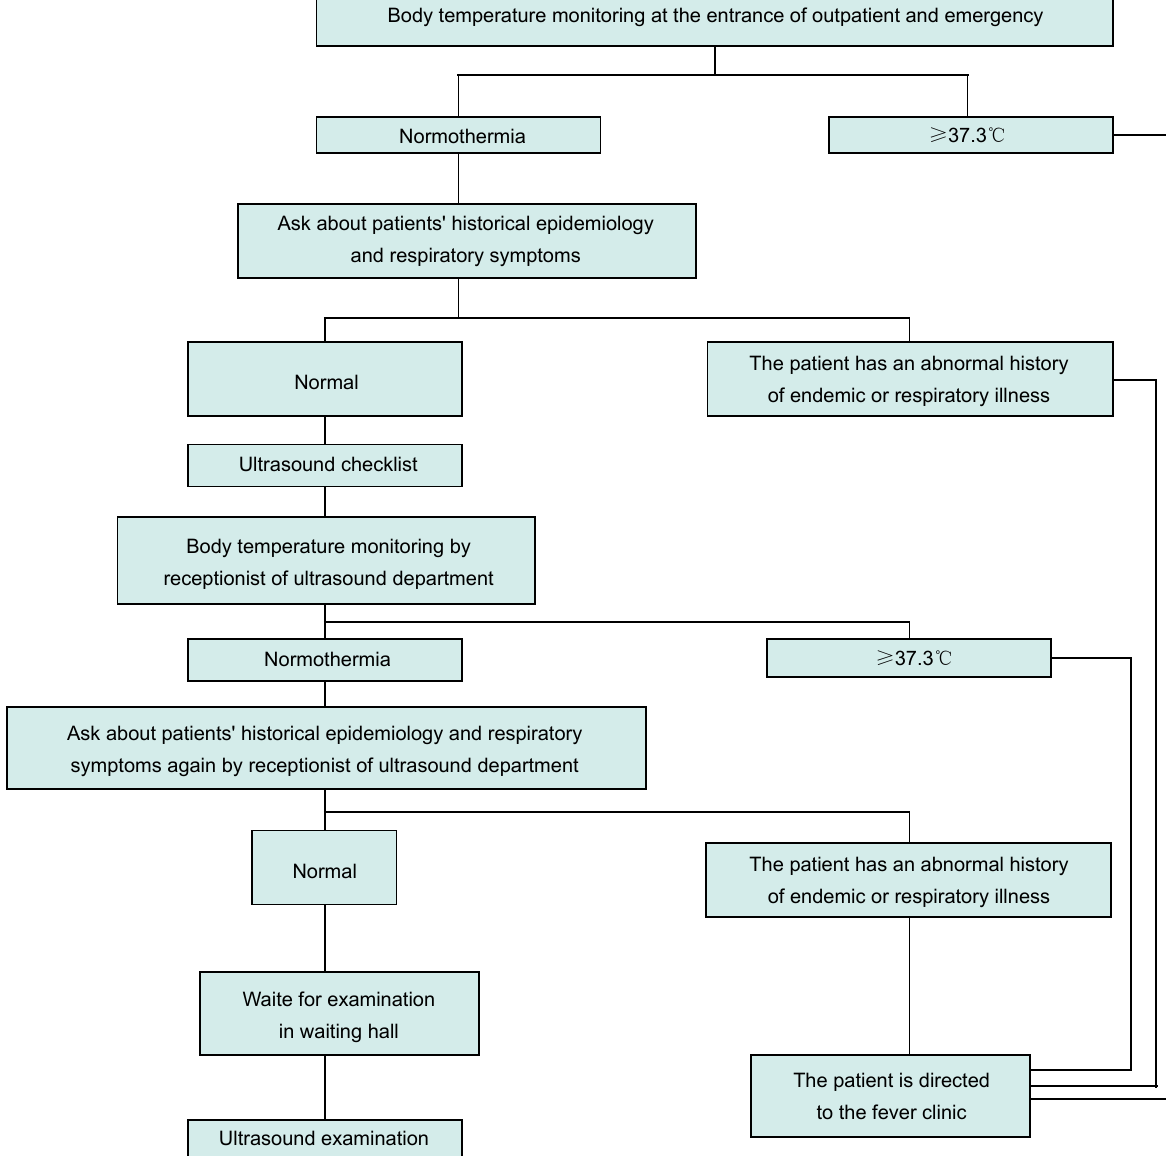
Figure 2 The illustration of hospital visit